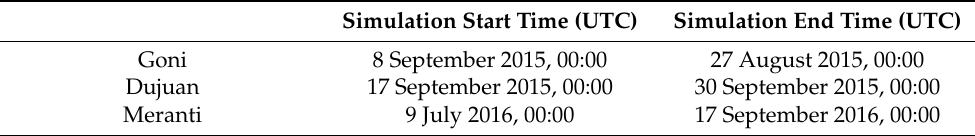
Table 2. The simulation start and end times of three typhoons.